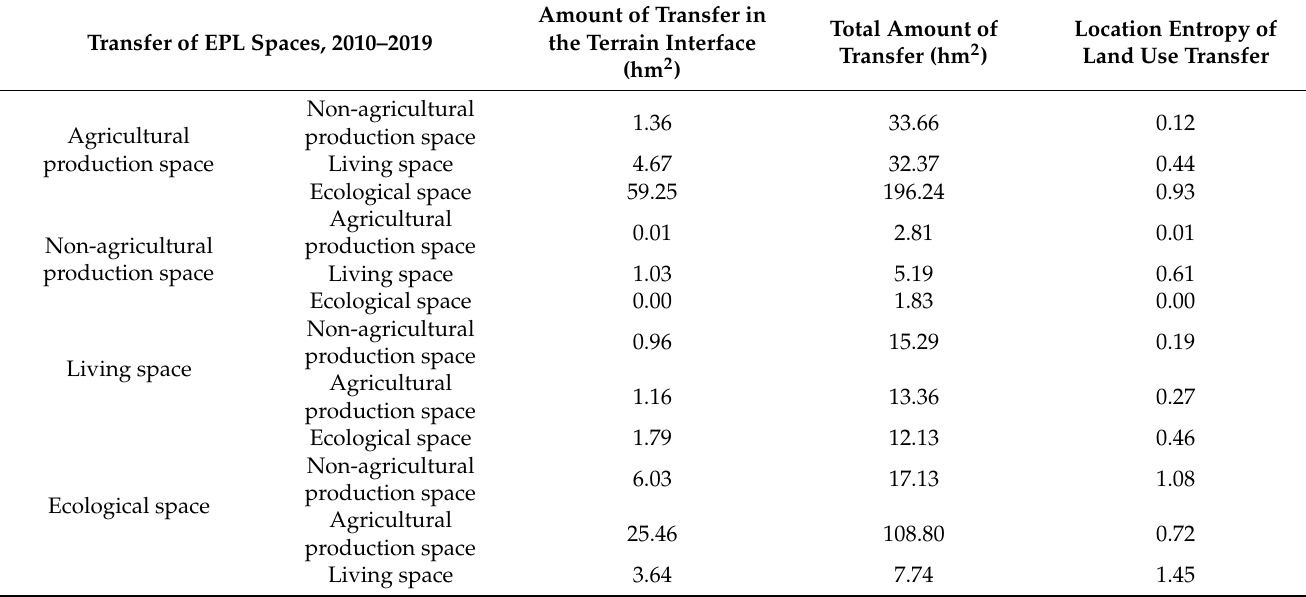
Table 7. Spatial transfer of EPL spaces in the terrain interface area from 2010 to